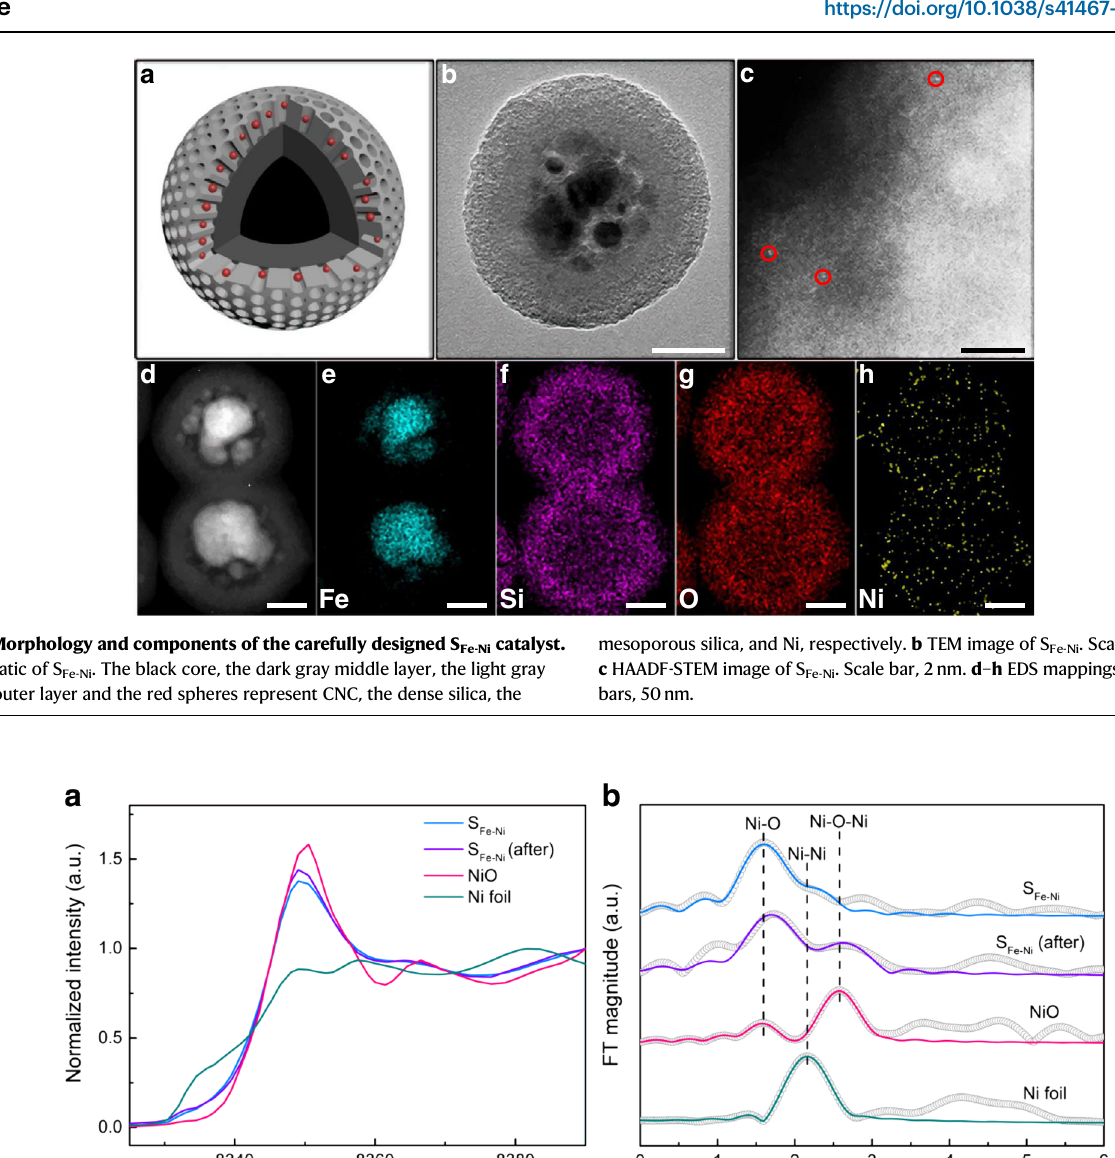
Fig. 3 | XAS fi nestructuresofthefreshand theusedS Fe-Ni catalysts.a NiK-edge XANES spectra of the fresh and used S Fe-Ni catalyst, exhibiting the normalized absorption intensity as a function of the X-ray photon energy. The used catalyst is denotedasS Fe-Ni (after).NifoilandNiOwereusedasreferences. b NiK-edgeEXAFS